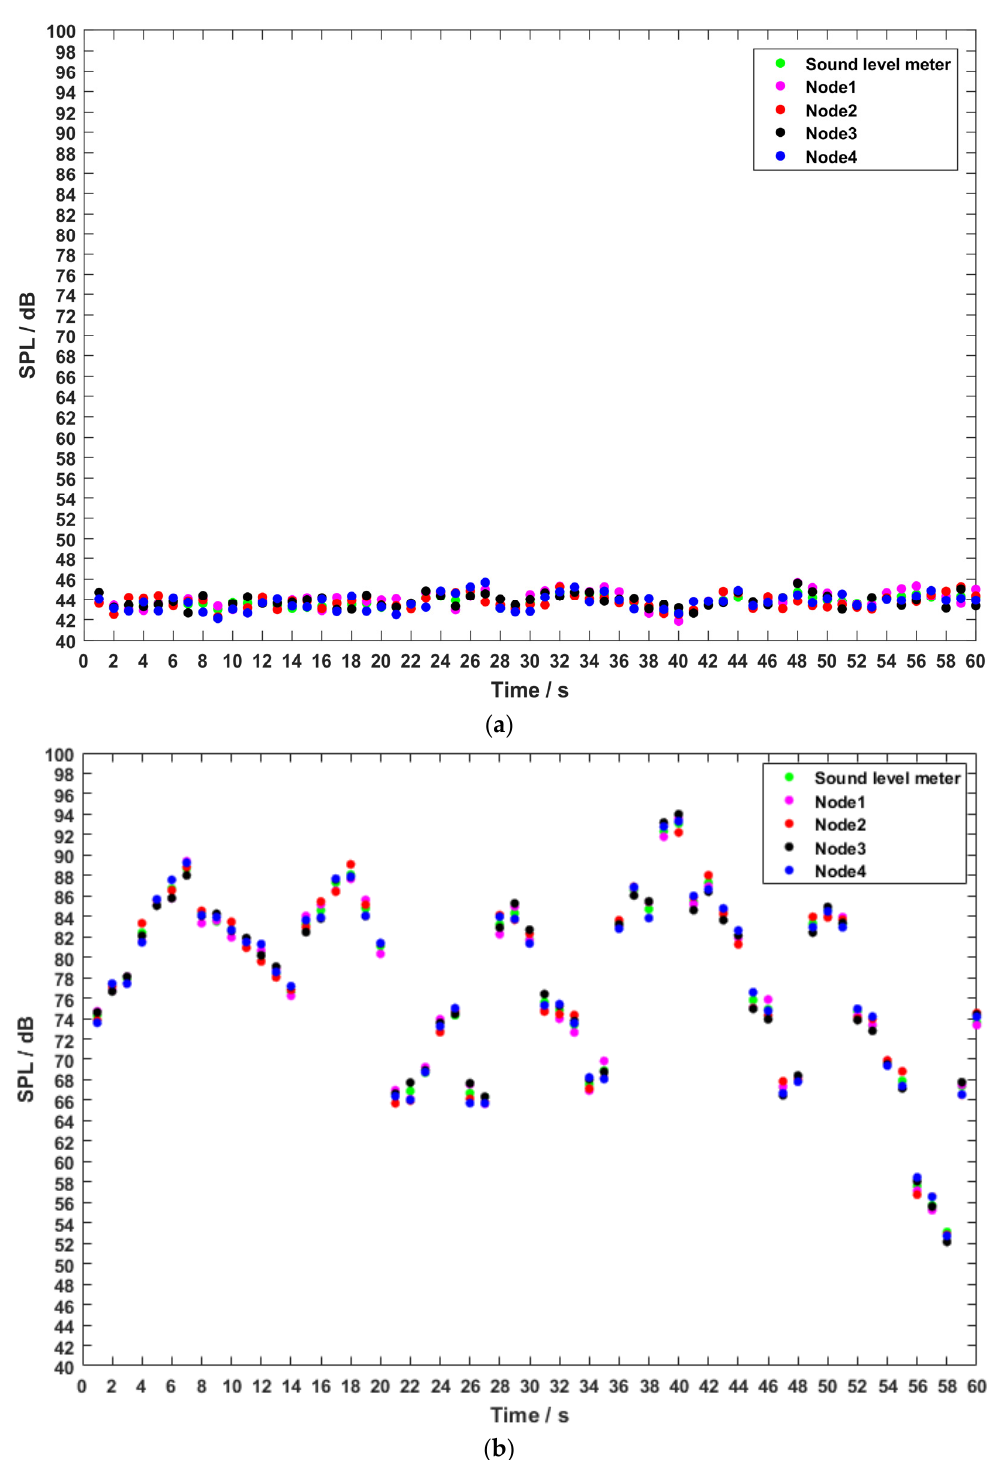
Figure 6. Data obtained from the sound level meter and the sensor nodes in the field test. ( a ) In the school road (low Signal to Noise Ratio (SNR)); ( b ) in the school gate (high SNR).